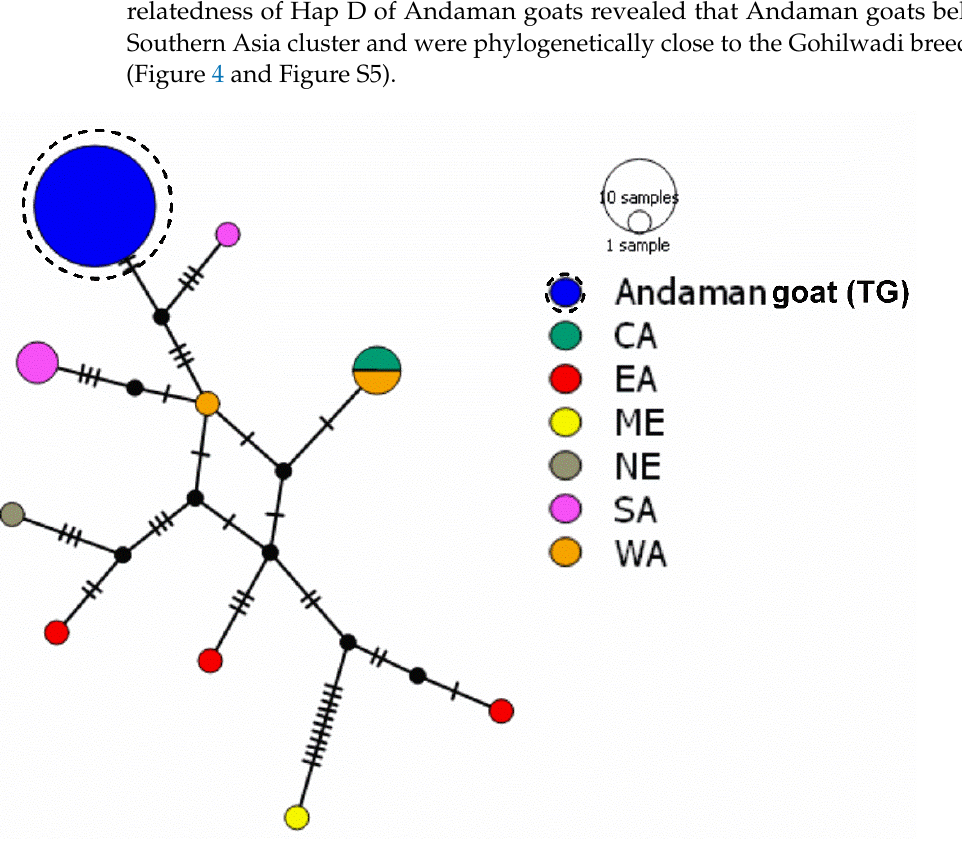
Table 3 . Pairwise FST values of haplogroup D goats of Andaman and other regions .